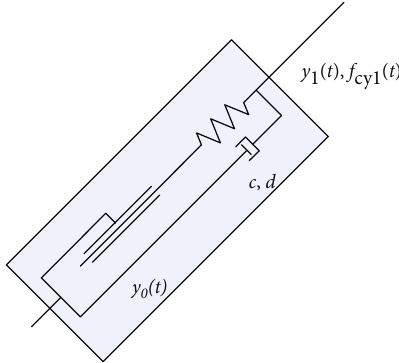
Figure 1: Physical model of patient transfer device hydraulic